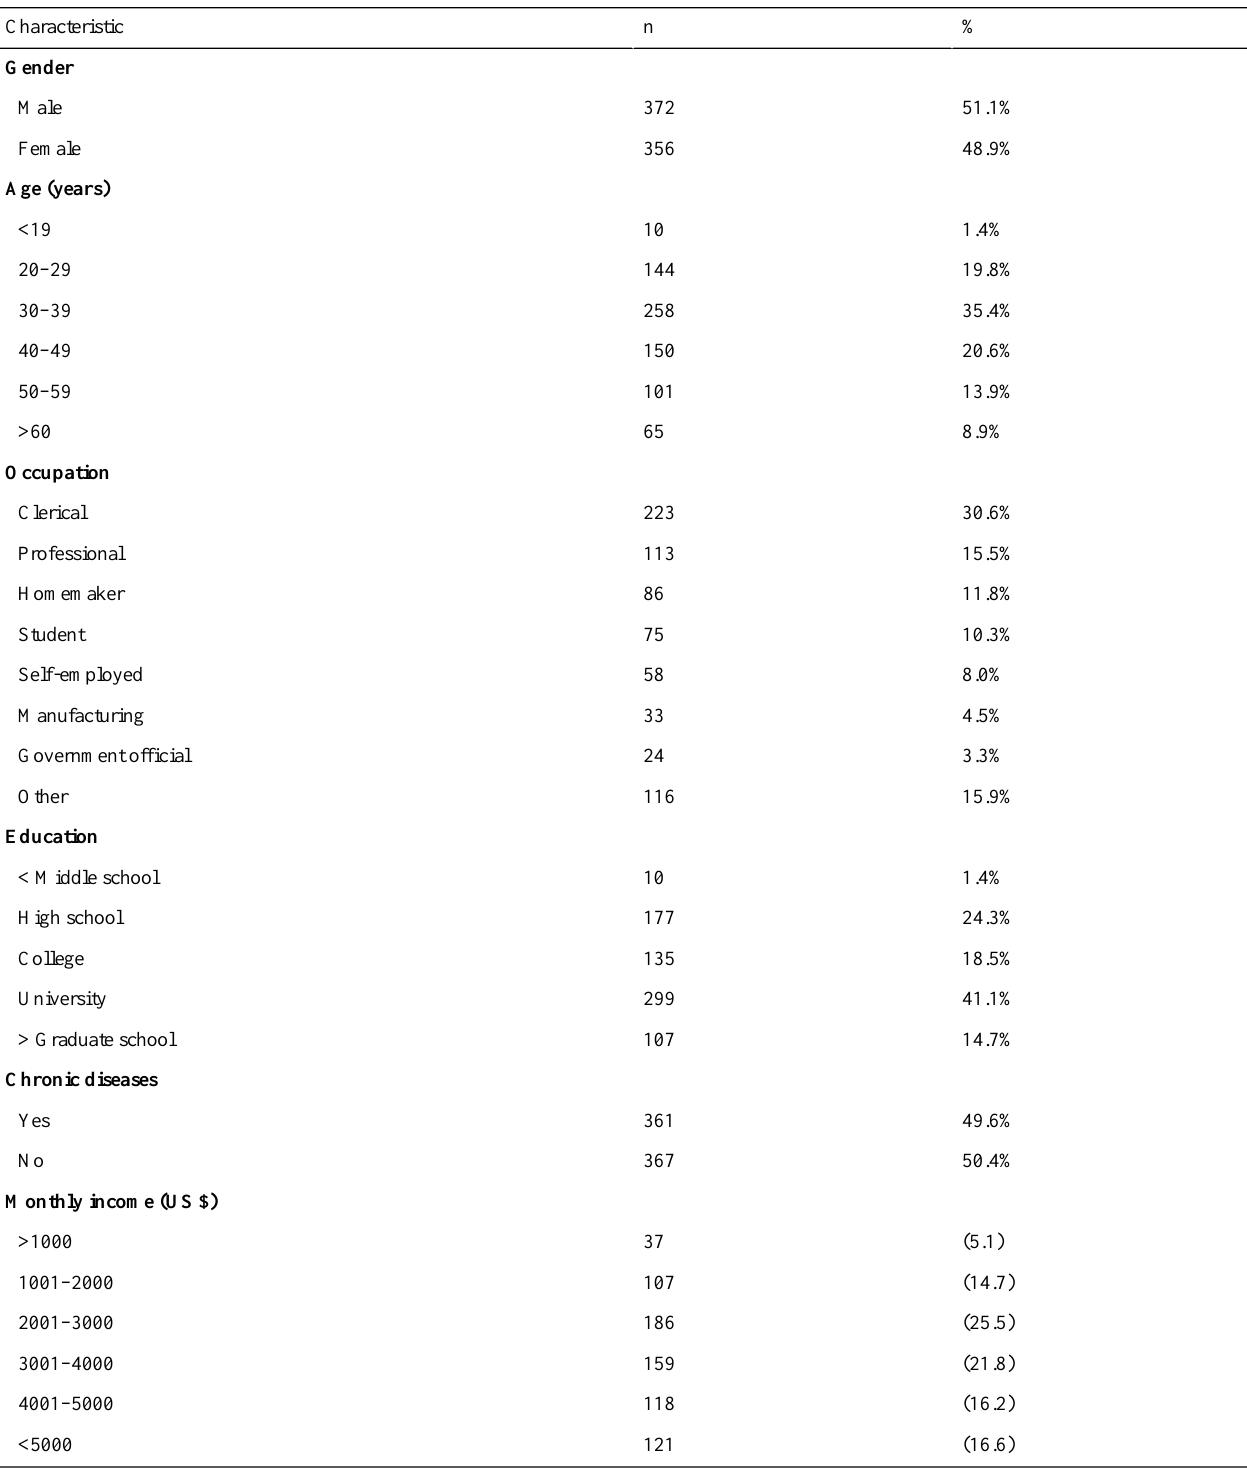
Table 2. General characteristics of the participants (N =